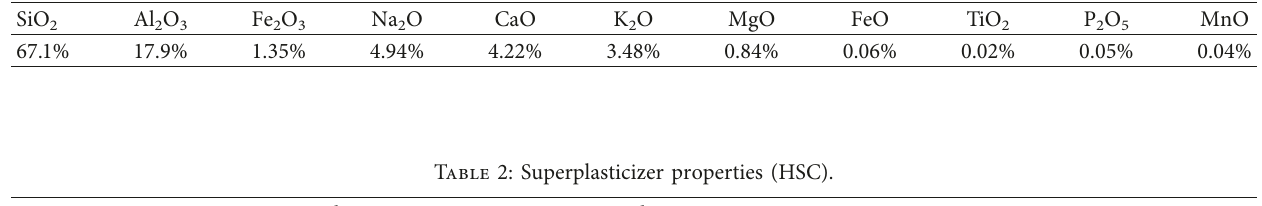
Table 1: The chemical composition of dune sand (Gurbantunggut